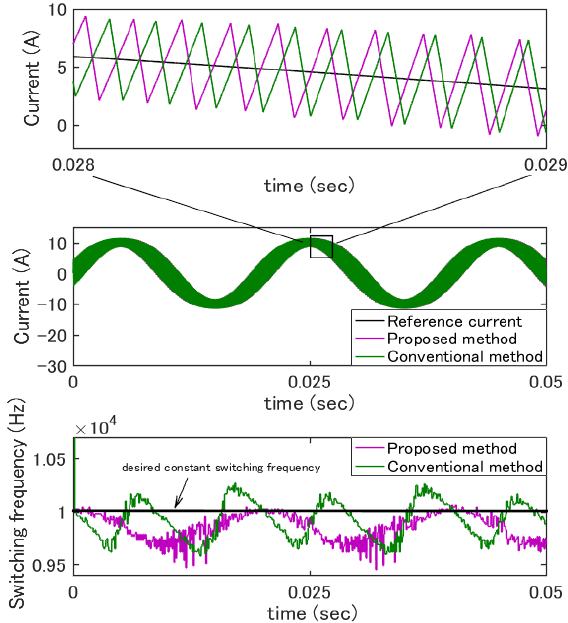
Figure 11. Current and switching period of the proposed method and conventional method for the desired switching frequency at 10 kHz.